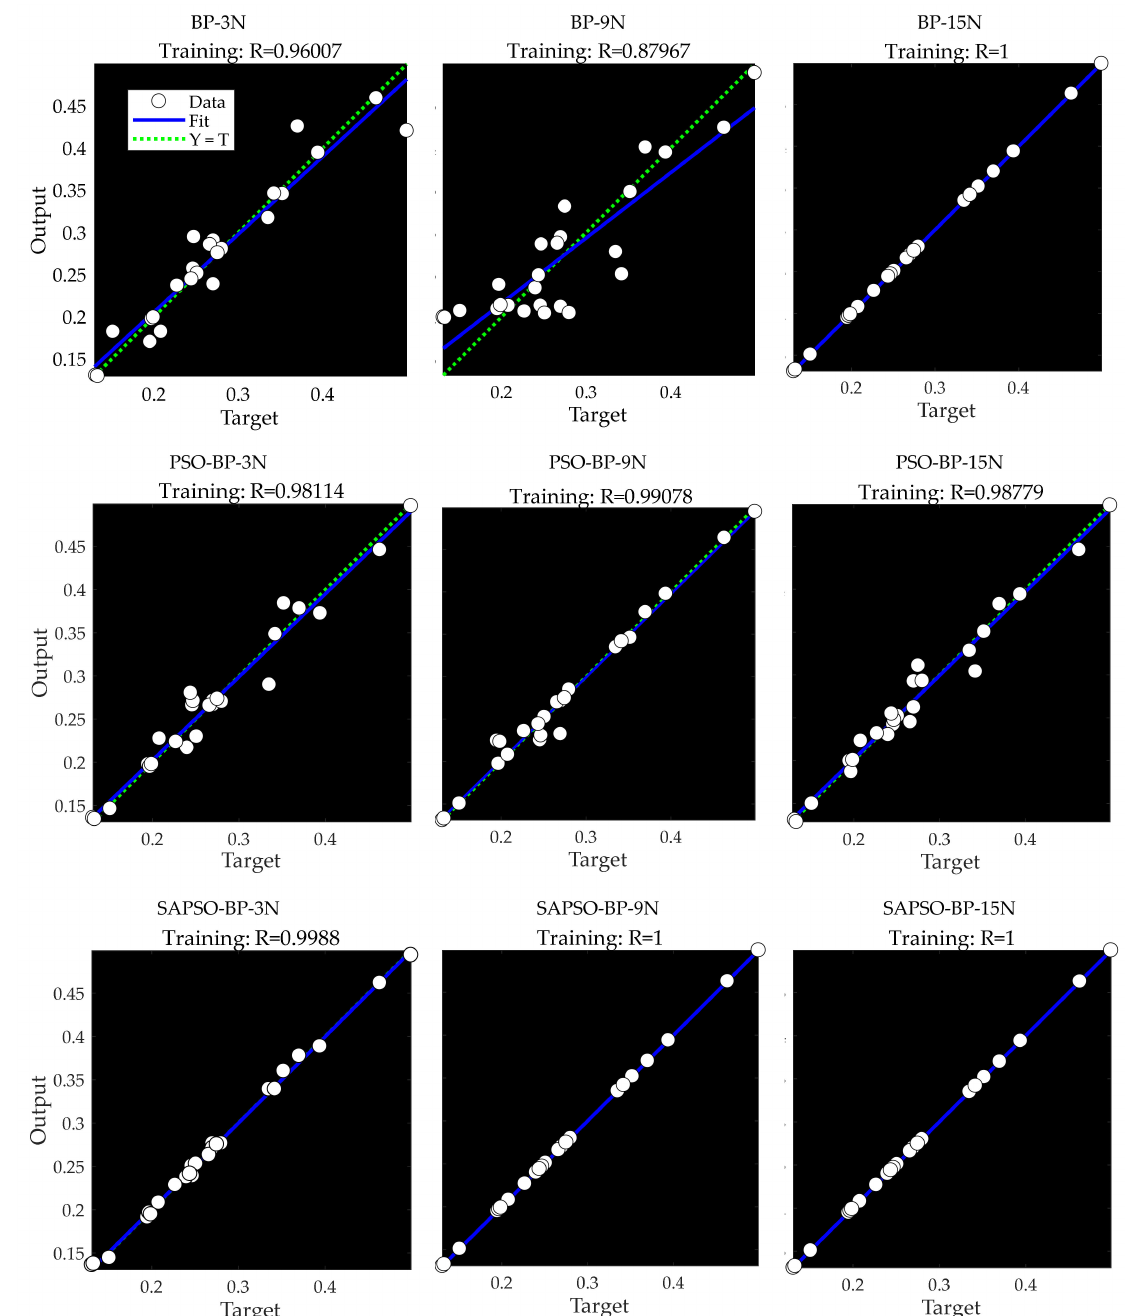
Figure 6. Regression curve of predicted electricity price and actual electricity price of 9